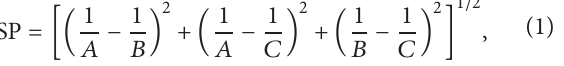
), relaxing energy ( replace 𝐸𝐸